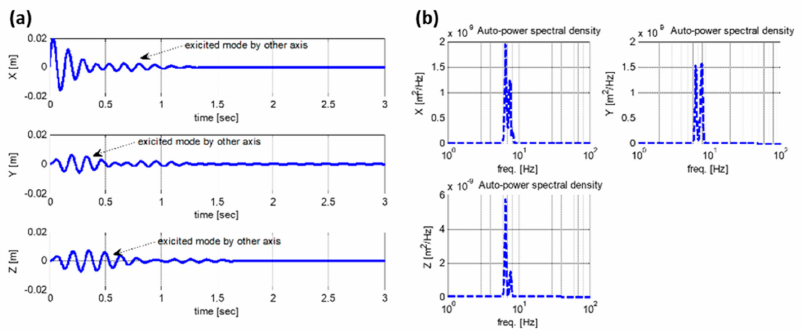
Figure 7. Simulation results of the coupled three-DOF mathematical model in ( a ) the time domain and ( b ) in the frequency